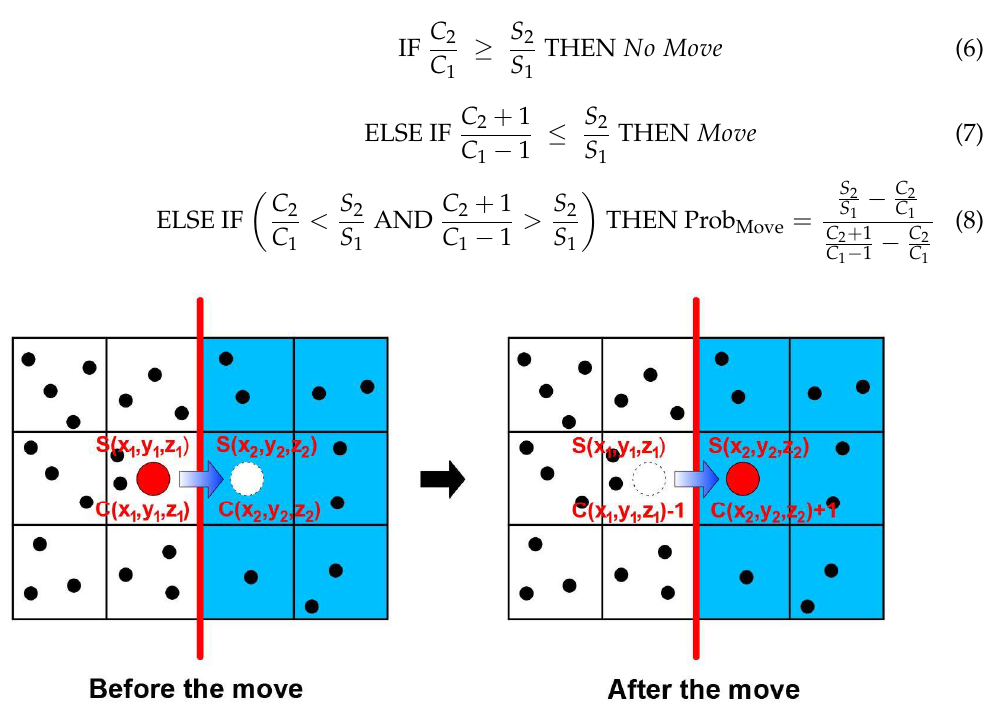
Figure 4. Schematic diagram of the potential migration of one molecule across the polymer–solid interface from phase 1 to phase 2 in an MMM.